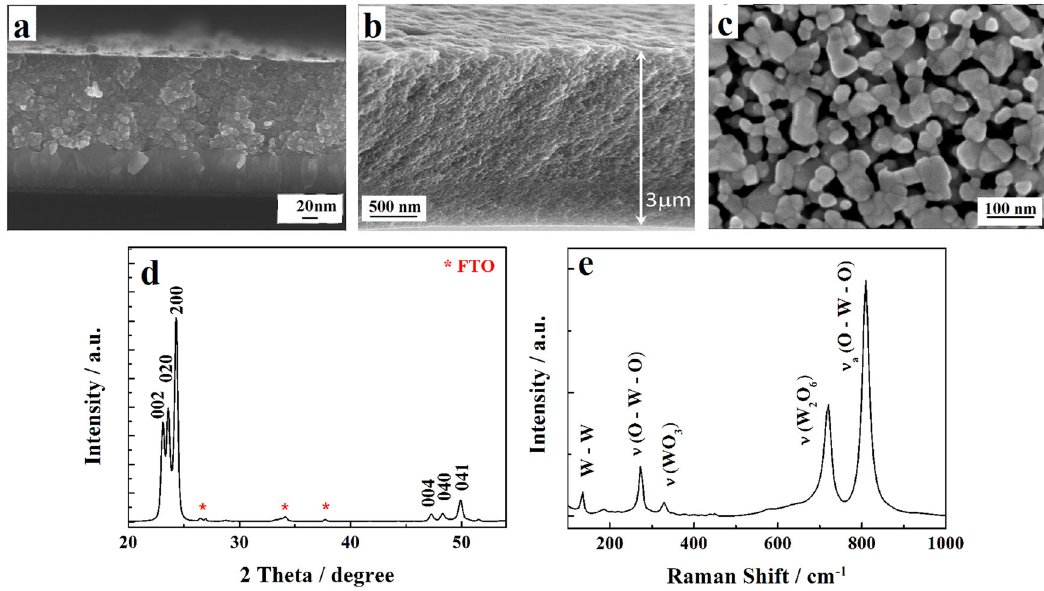
Fig. 1 Morphological and structural characterization of NS tungsten trioxide electrodes. a and b , Cross-sectional SEM images of ~ 1.2 μ m ( a ) and ~ 3 μ m ( b ) thick WO 3 fi lms. c , top-down SEM image of the fi lm in ( a ). d , X-ray diffraction pattern of WO 3 fi lm in ( a ). e , Raman spectrum of WO 3 fi lm in ( a